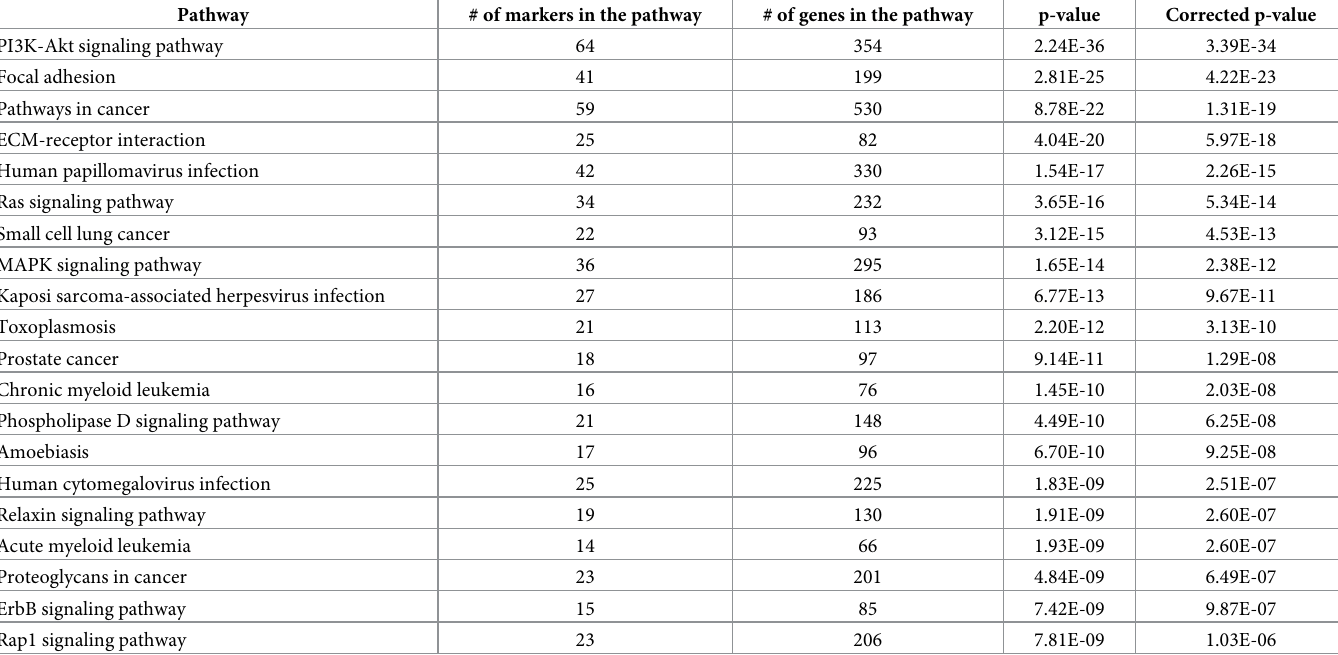
Table 4. Top enriched KEGG pathways by the genes and proteins in the largest connected subnetwork. Pathway # of markers in the